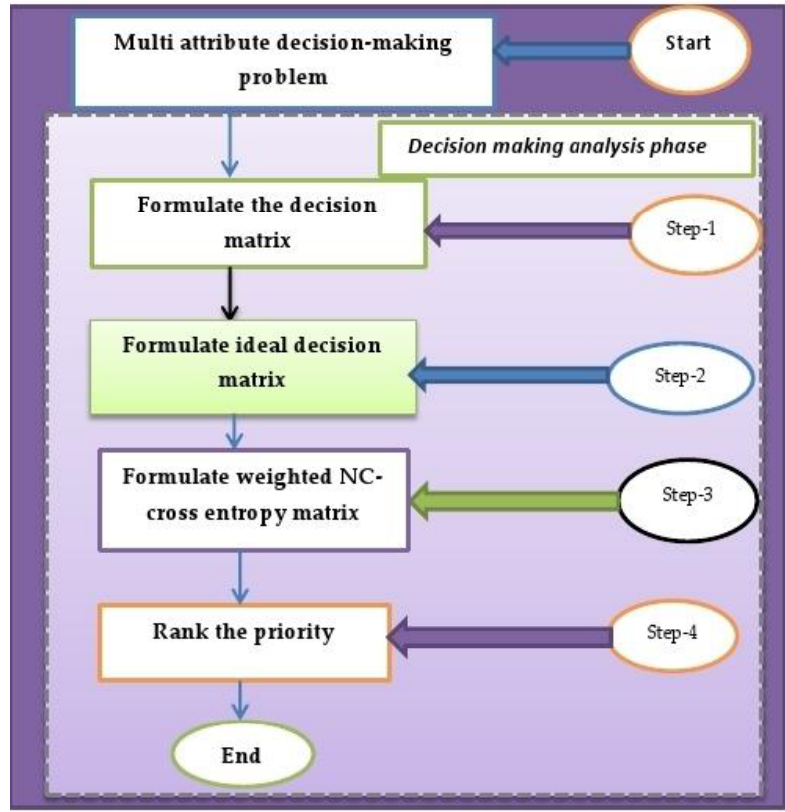
Figure 1. A flow chart of the NC-cross entropy based MADM strategy.